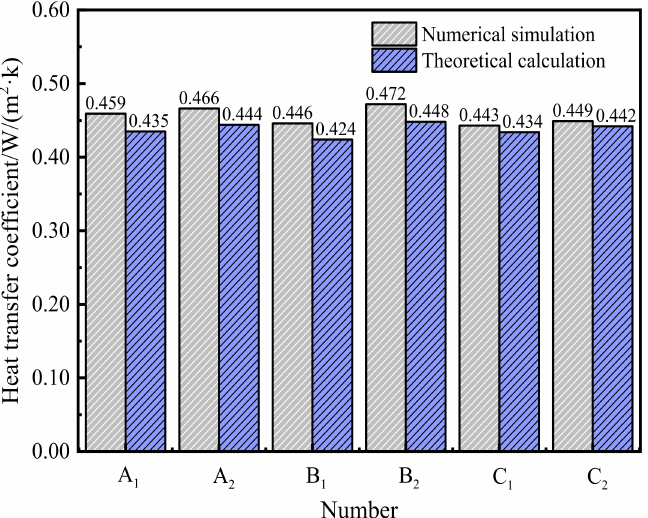
Figure 12. Comparison of simulated and calculated values of heat transfer